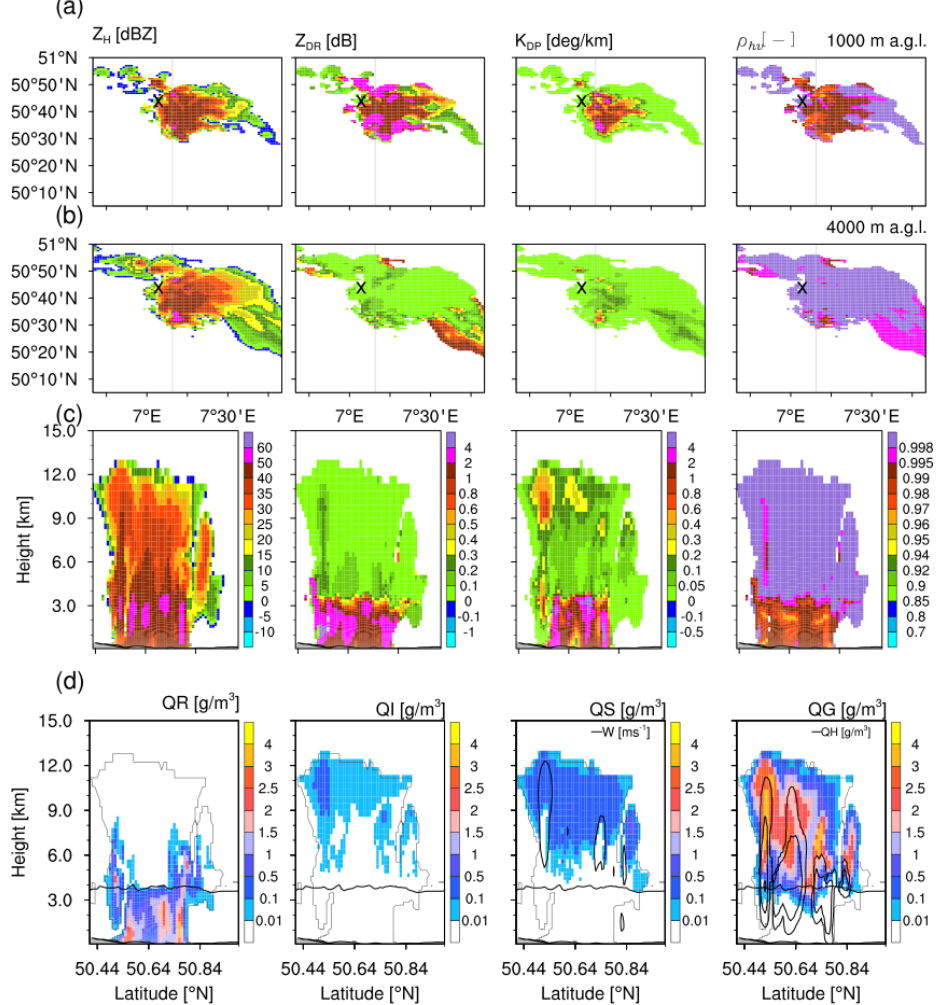
Figure 10. (a, b) Model-simulated horizontal reflectivity, differential reflectivity, specific differential phase and cross-correlation coefficient at low level (1000ma.g.l.) and near the melting layer (4000ma.g.l.) on 6 July 2017 at 15:30UTC. The “ × ” symbol refers to the BoXPol location. The solid grey line indicates the location of the cross section. (c) Cross section of the same polarimetric variables. (d) Cross section of model-simulated hydrometeor density – Q R (rain), Q I (ice), Q S (snow), Q G (graupel) and Q H (hail). Also shown are the 0 ◦ C line (solid black line) indicating the melting layer, contours of vertical velocity [5, 40ms − 1 ] with Q S and contours of the Q H with Q G.